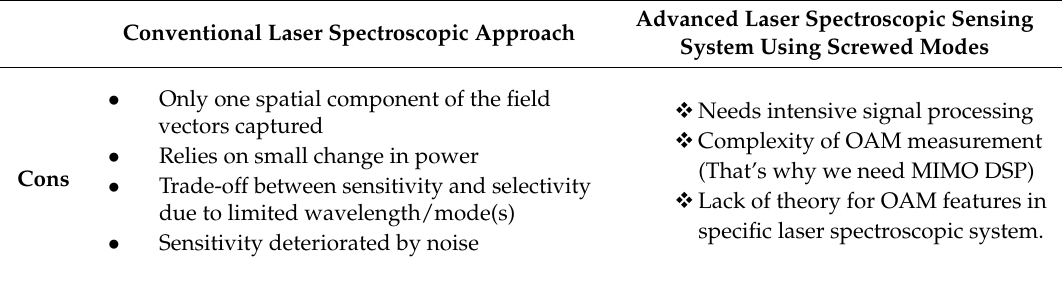
Table 3. Cont . Table 3. The benefits of using screwed modes in the laser spectroscopic sensing systems in comparison with the conventional approach.